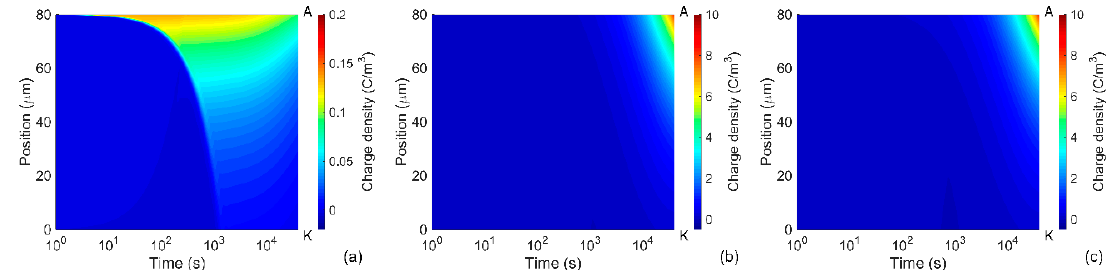
Figure 5. Distributions of charge densities in LDPE nanocomposite obtained from simulations at room temperature: ( a ) mobile charges; ( b ) trapped charges; and ( c ) total space charges. Positions of the anode and cathode are indicated by letters A and K, respectively.